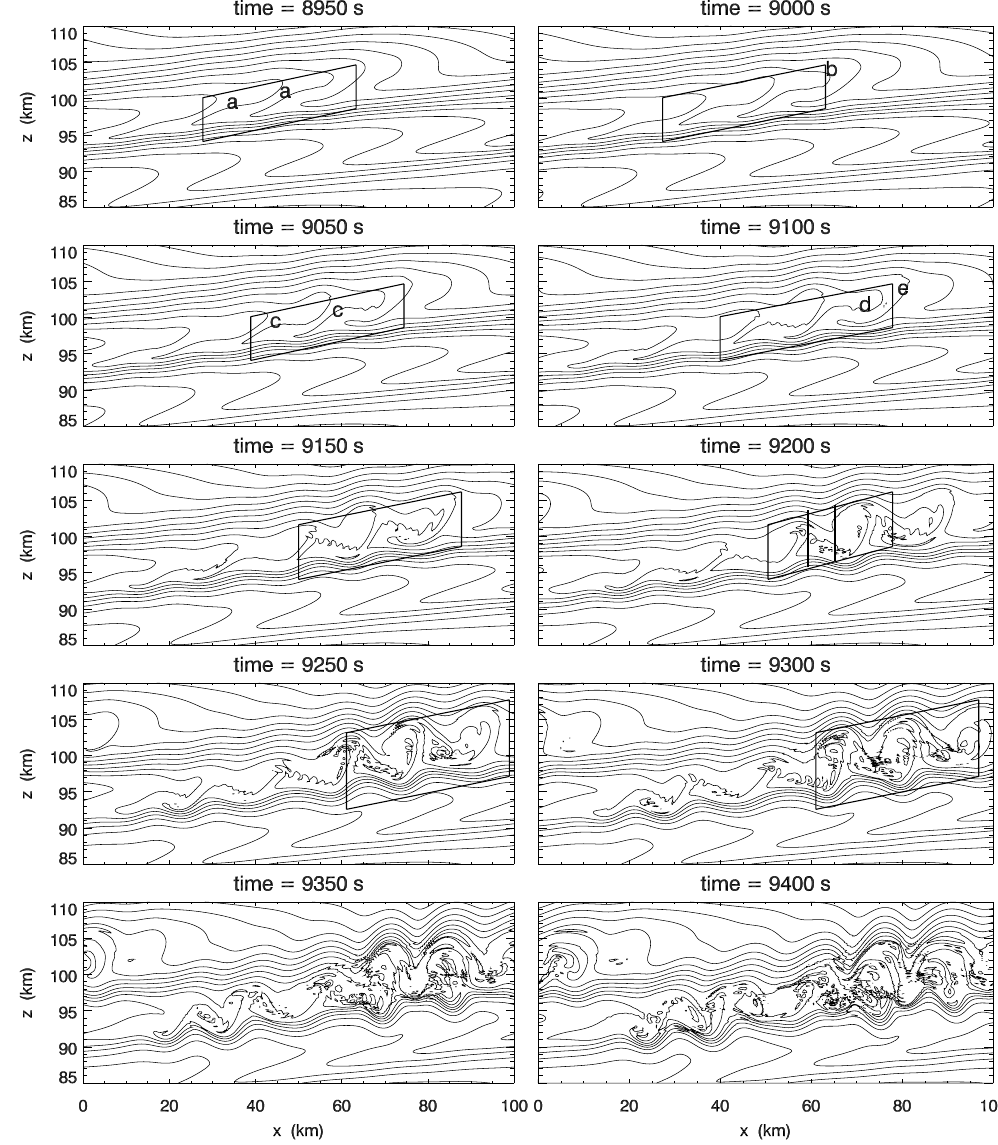
Fig. 2. Contour plots of the total potential temperature during GW propagation. These figures also present the evolution of KH